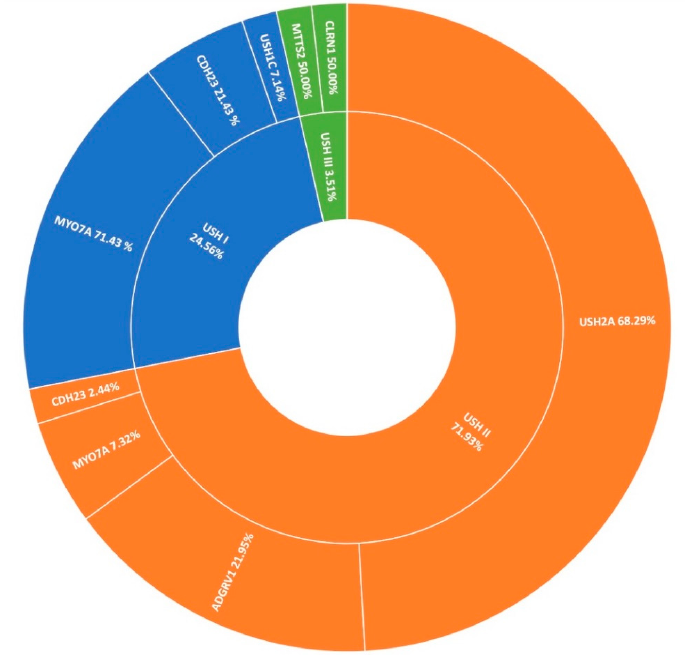
Figure 7. A summary of the genetic architecture of Usher Syndrome (USH) in Target 5000 participants (Table